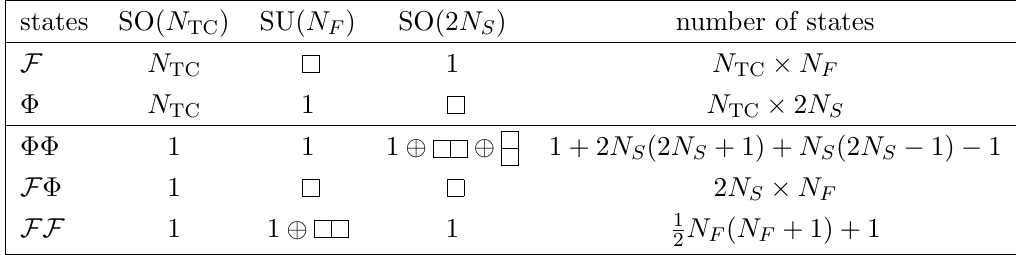
Table 1 . Fundamental and composite matter (cid:12)elds for G TC = SO( N TC ). N F ( N S ) is the number of TC-fermions